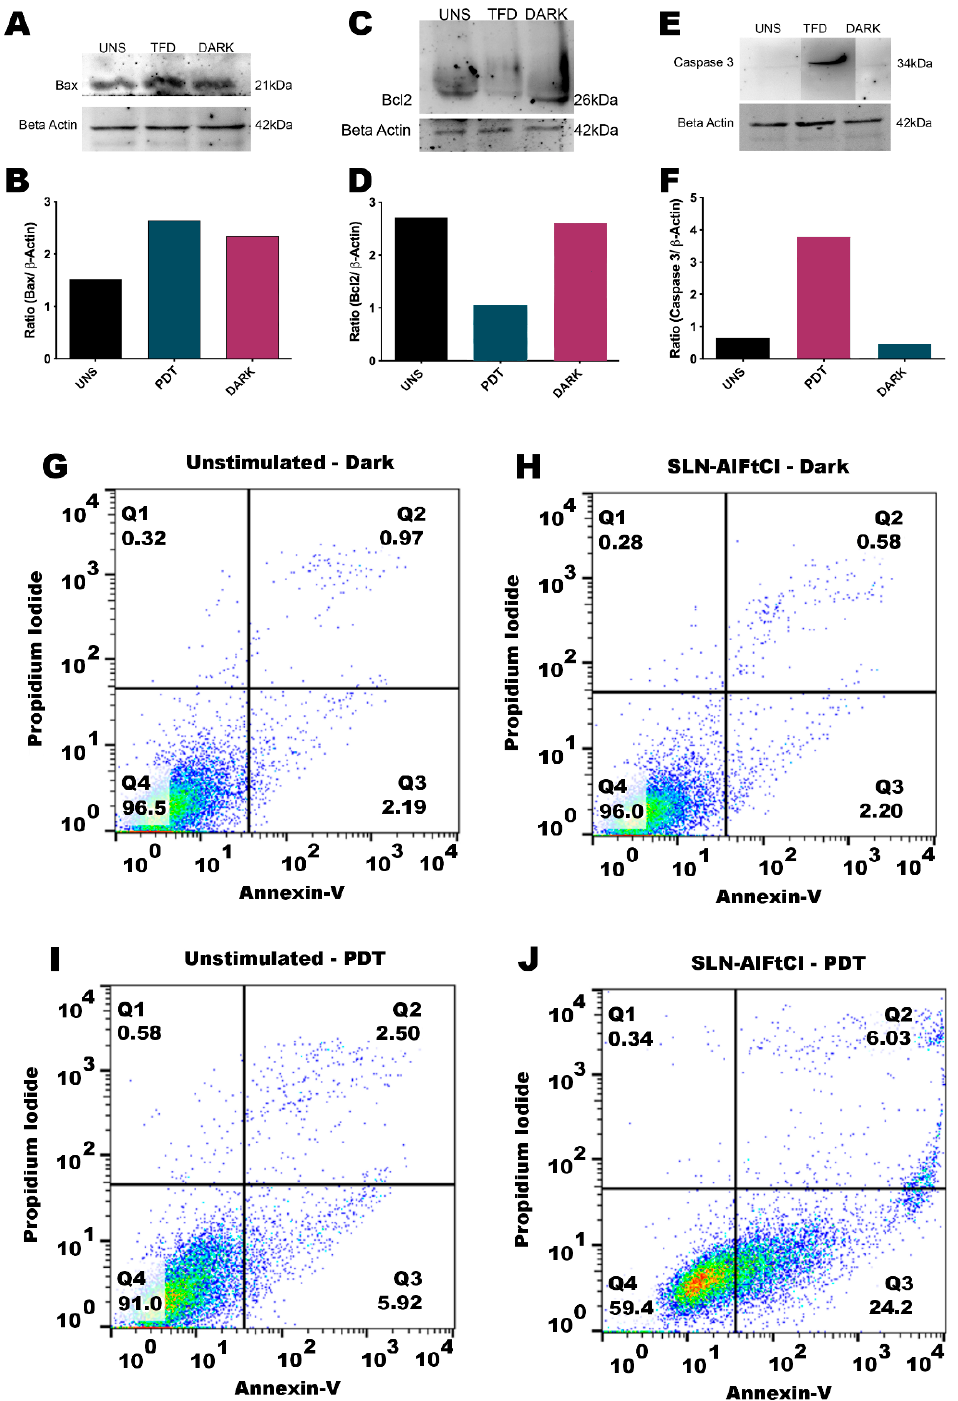
Figure 16. Analysis of apoptotic cell death. Apoptosis was evaluated by Western blot ( A – F ) and flow cytometry ( G – J ). Western blot images of Bax ( A ), Bcl2 ( C ), and caspase 3 ( E ) bands as well as the loading control (beta acting) bands. Pixel quantification of Bax ( B ), Bcl2 ( D ), and caspase 3 ( F ) bands to the loading control bands. Apoptosis was induced by phosphatidylserine under different treatment conditions ( G – J ). Q1 represents the Propidium Iodine positive signal, which is a marker for necrosis. Q2 represents both propidium iodide (necrose) and Annexin-V (Apoptose) positive signal. Q3 represents only Annexin-V positive signal, and Q4 represents no positive signal and, therefore, no cell death.